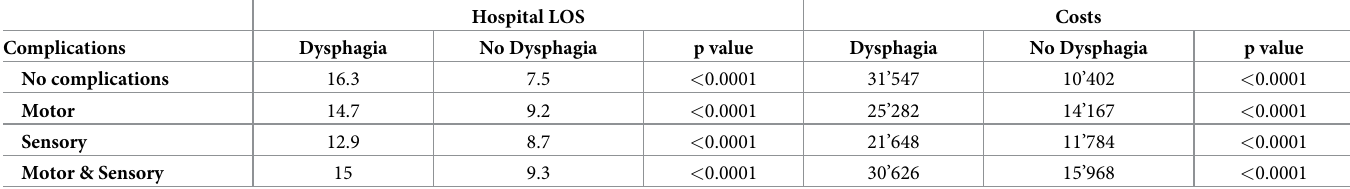
Table 6. Hospital LOS and Costs of Hospital stays for stroke with vs. without dysphagia by subgroups in